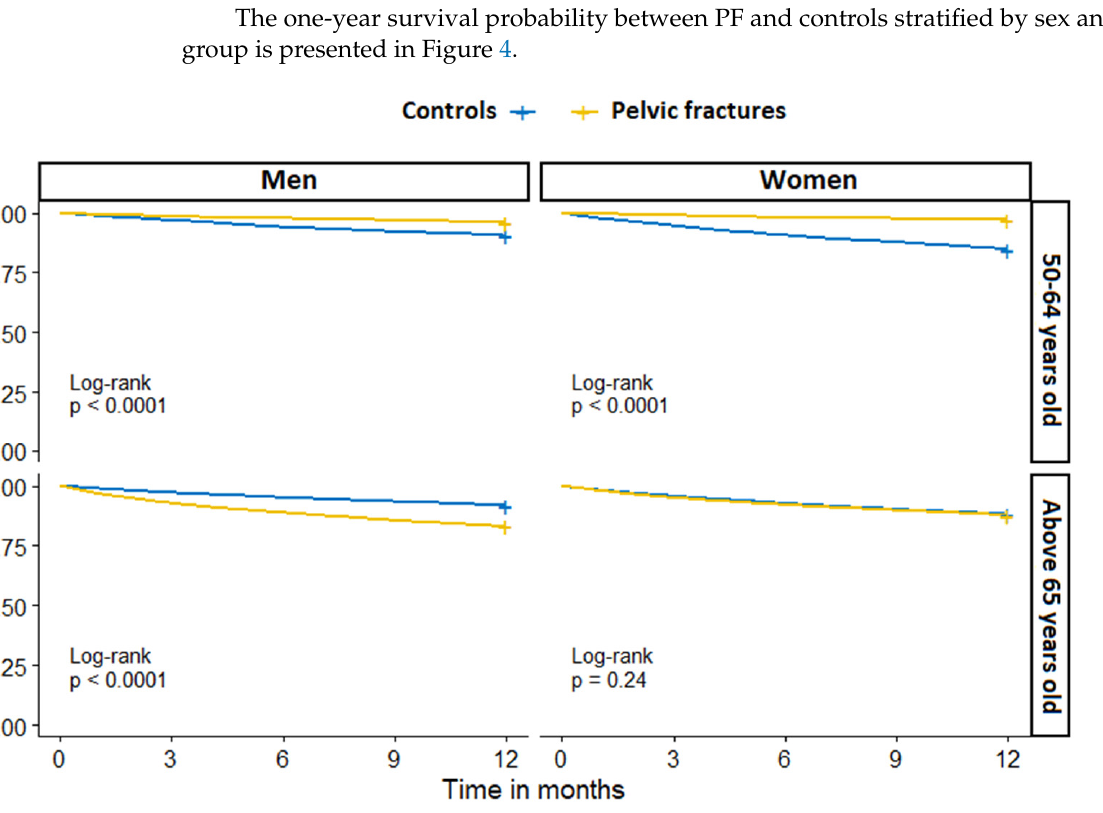
Table 2. One-year mortality after pelvic fracture and in matched fracture-free controls, stratified by age group and sex; n = number of deaths. Pelvic Fractures Controls Age Group All Men Women All Men